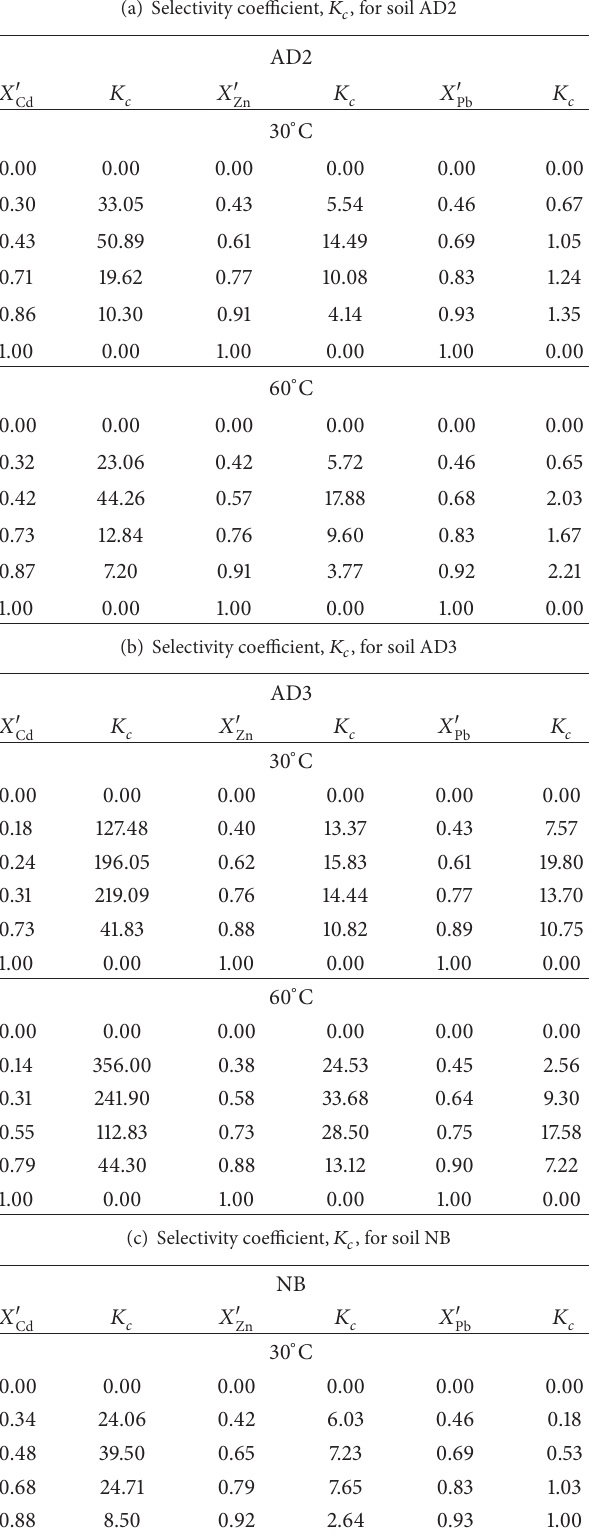
Table 3: Selectivity coefficient, 𝐾 𝑐 , as a function of soil phase com- position in Ca 2+ → M 2+ exchange at 30 ∘ C and 60 ∘ C in the different soils